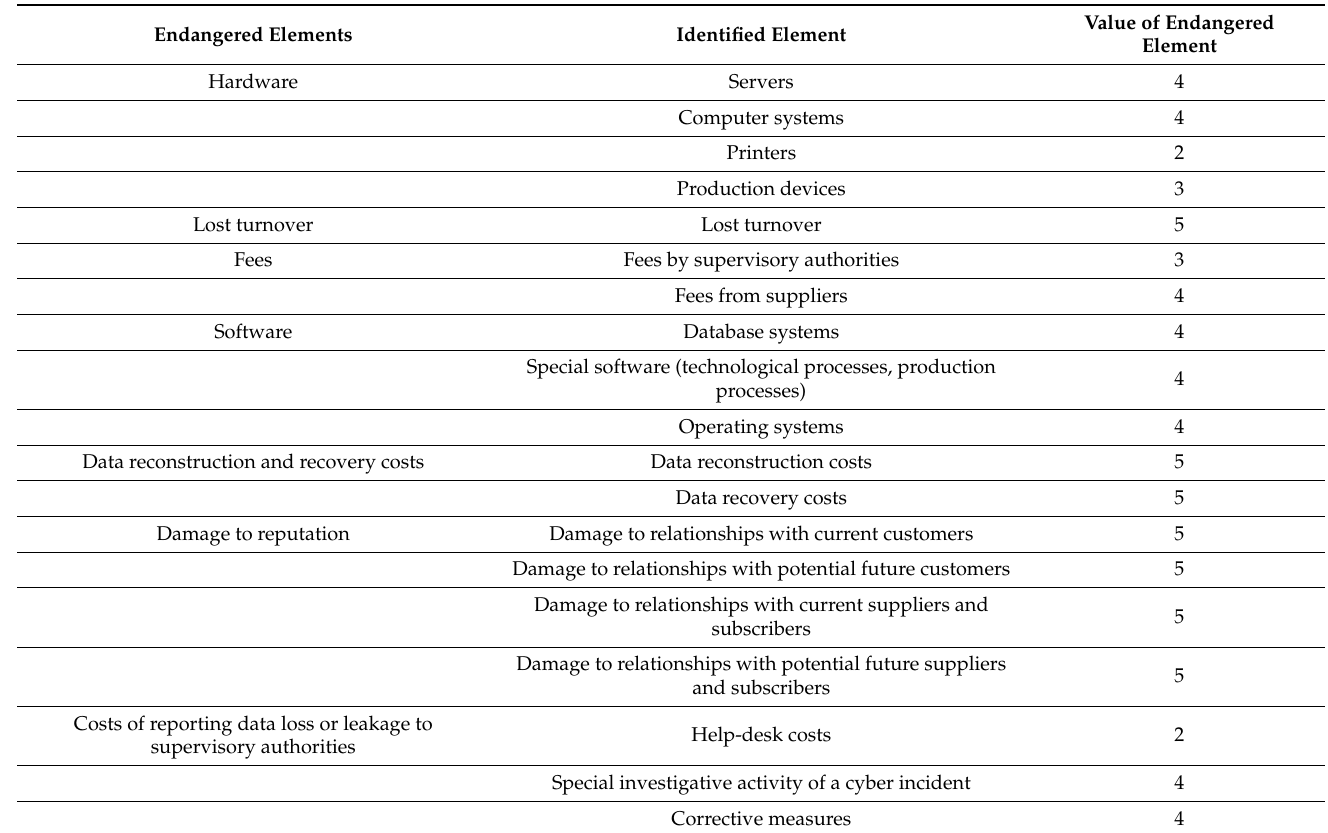
Table 3. Values of endangered elements (own